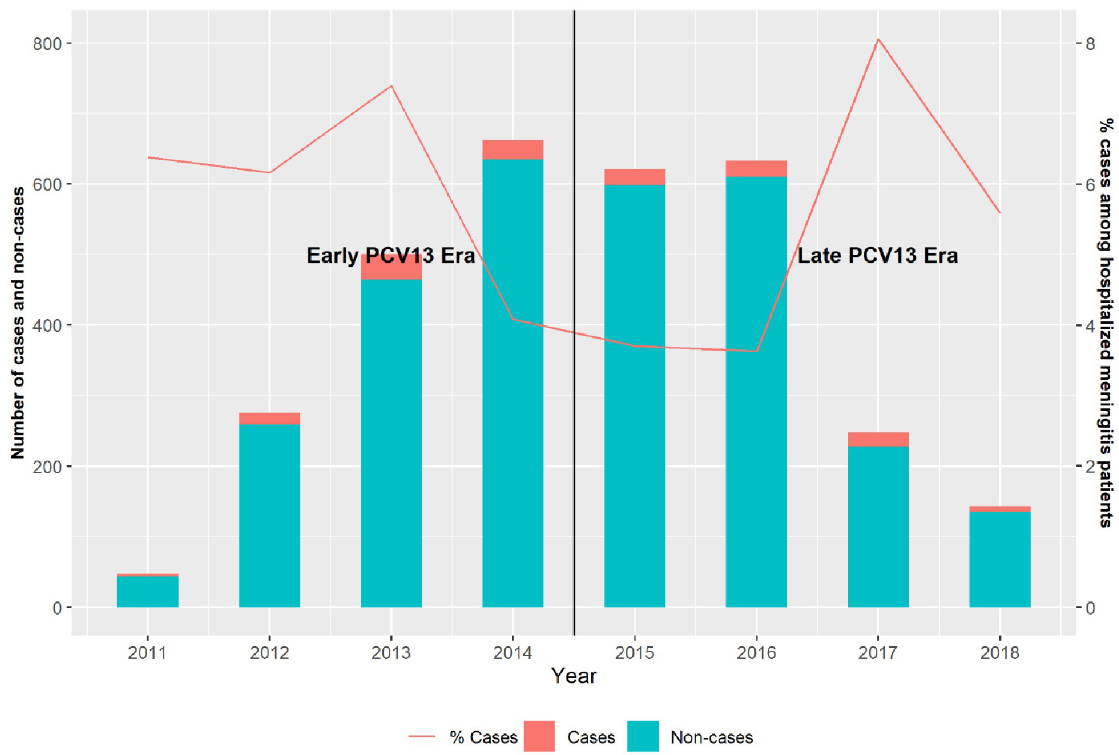
Fig 1. Profile of meningitis (purulent [Cases] and non-purulent [Non-cases]) in 2- to 59-month-old children hospitalized in Yaounde´, 2011 – 2018. Note: PCV13 = 13-valent pneumococcal conjugate vaccine; CSF = cerebrospinal fluid; WBC = white blood cell; Cases = Purulent meningitis patients with a CSF WBC count � 20 per mm 3 ; Non-cases = Meningitis patients with a CSF WBC count < 20 per mm 3 .